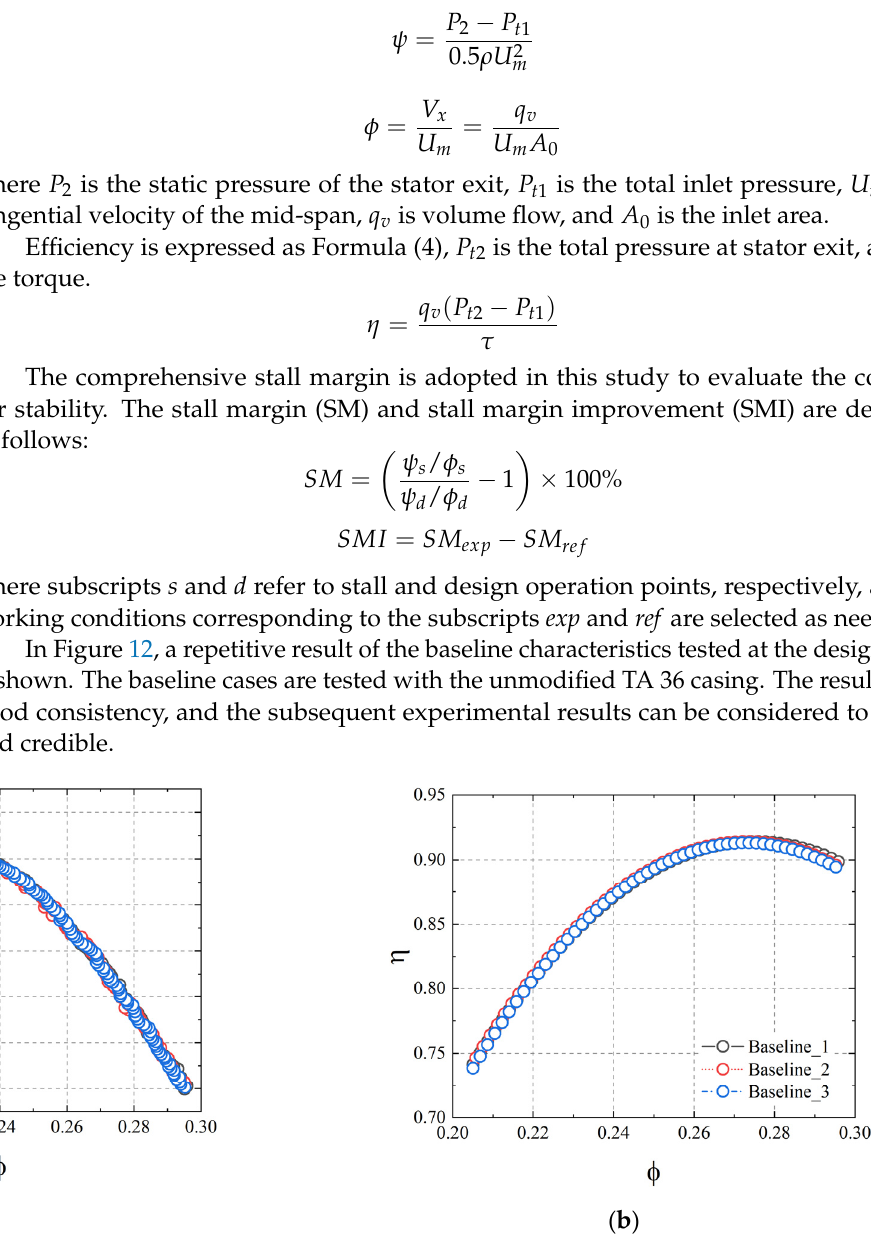
( b ) Figure 13. The results of the oscillator–compressor experiments: ( a ) pressure rise characteristics; and ( b ) efficiency characteristics. In Figure 13a, compared with the baseline (SP 1), test casing (SP 2) itself can obviously improve the stall margin; meanwhile, it also has a significant efficiency loss of 2.77%. This is because of chambers in the rotor tip region after the casing and oscillators are assem- bled, as shown in Figure 5. The special structure of the test casing is designed by consid- ering the safety and the related parameters of tip injection and casing treatment, which mainly include circumferential coverage and porosity. Studies [13,44] have shown that with the increase of the circumferential coverage of the tip injection, the SMI also in- creases, and the trend is basically first fast and then slow. The oscillators used in this ex- periment have two outlets, and the width of each is only 2 mm. When 15 oscillators are applied, the circumferential coverage of air injection is only 1.592%, and considering that the flow rate of air injection is only 0.08% of the compressor’s designed flow rate, cham- bers are left on the casing. In these chambers, the momentum of the injected air is aver- aged, thereby expanding the circumferential coverage of the excitation to 20 times the